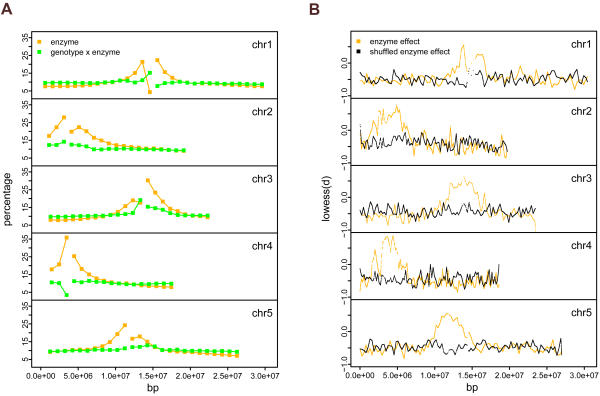
Genomic Distribution of Constitutive and Polymorphic CG Methylation Sites.(A) Percent constitutive (orange) or polymorphic (green) CG methylation sites (y-axis) along chromosomes. The x-axis indicated the chromosome positions in bp. The gaps on each chromosome indicated the positions of BAC clones for centromere sequences. Each chromosome was divided into 1 Mb bins starting from the ends of the centromere gap toward chromosome arms. For each bin, percent constitutive or polymorphic CG methylation sites was calculated as the number of features containing constitutive or polymorphic CG methylation divided by the number of CCGG-containing features. (B) Co-methylation along chromosomes. The d scores of enzyme effect for 54,519 CCGG-containing features were Lowess-smoothed with a window size of 200 kb (orange), or were shuffled by 1 kb block and Lowess-smoothed with a window size of 200 kb as a null distribution (black). The smoothed d scores (y-axis) were plotted along chromosome positions (x-axis).